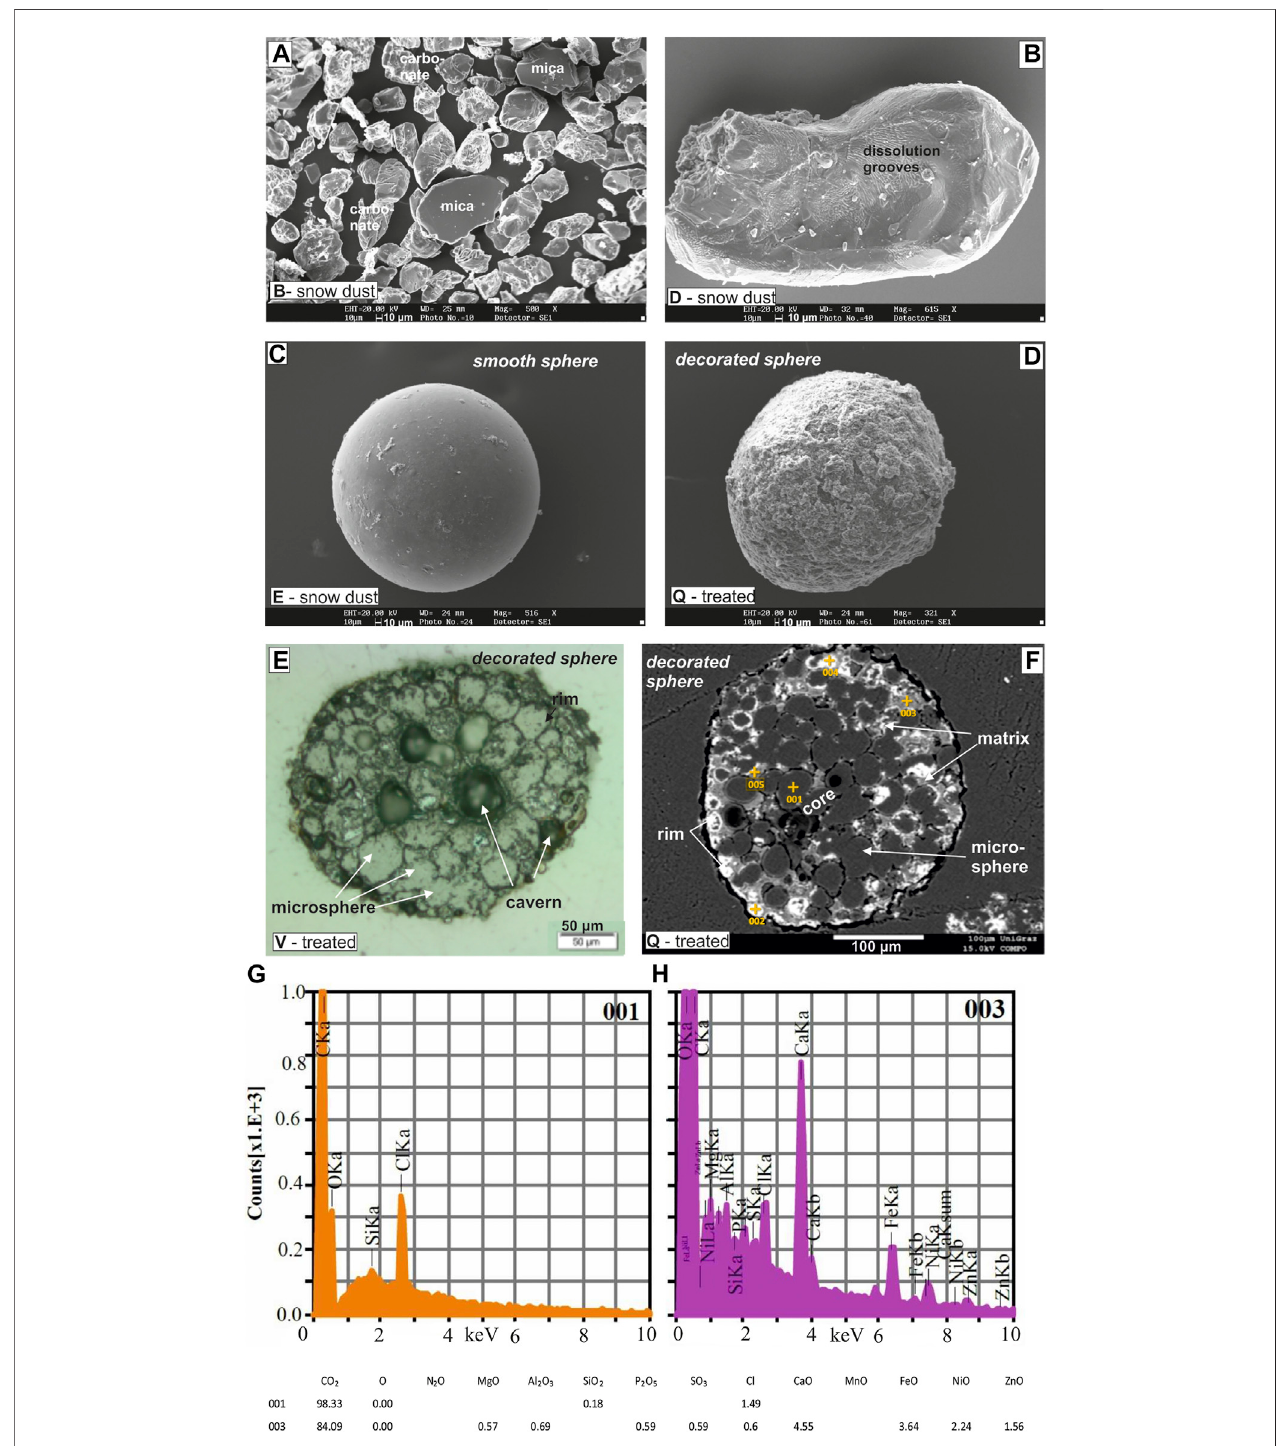
FIGURE 2 | (A) Overview of various mineral grains by scanning electron microscope. (B) Etched quartz grain and their surfaces. (C) Perfect sphere with a smooth surface interpreted as a micrometeorite. (D) Sphere with decorated, grainy surface interpreted as fl y ash (see discussion). (E,F) Internal structure of the decorated spheres. (A – D) and (F) Scanning electron microscope, (E) Optical microscope. Representative EDS spectra of microspheres of samples 001 and 003 in Q2. (G) Microsphere is rich in carbonaceous material, oxygen, and some chlorine (location 001). (H) is from margin of the decorated microsphere and is rich in carbon, oxygen, calcium, and some other metals (location 003, see counts of elements below).